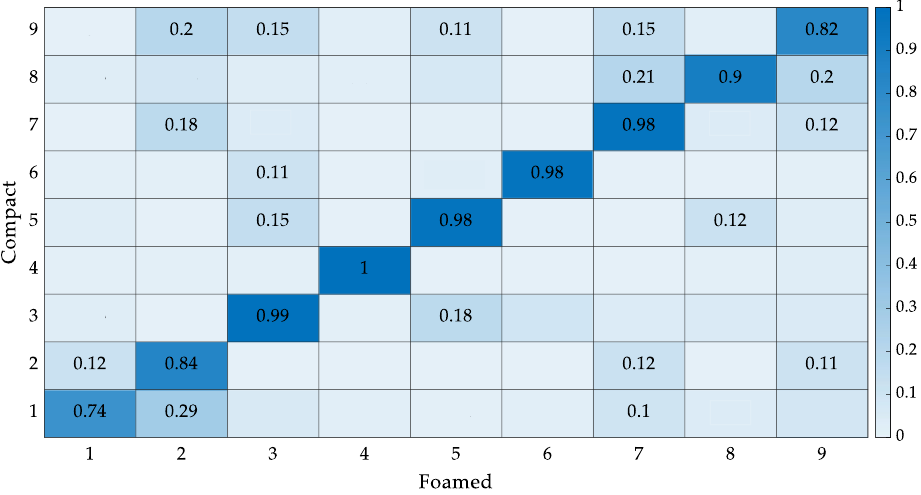
Figure 24. MAC matrix. Mode shapes above a MAC value of 0.1 are displayed.